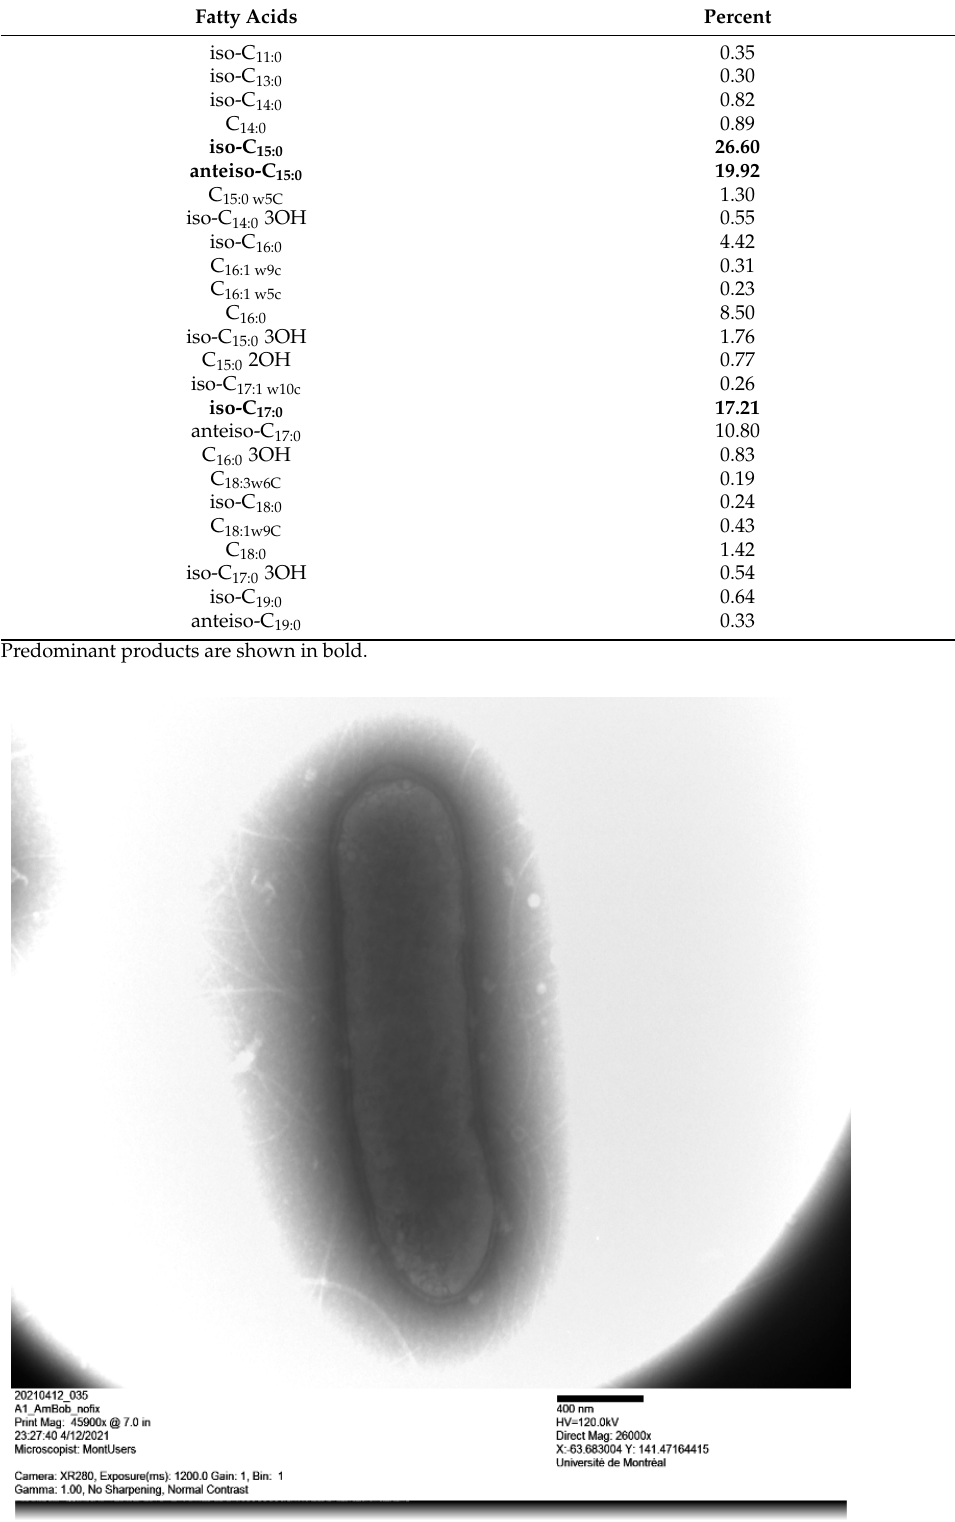
Figure 2. Transmission electron microscopy of Alistipes montrealensis strain kh20 T using a Tecnai G20 transmission electron microscope. Table 1. Differential phenotypic features between strain kh20 T and closest related species [9]. 1, A.